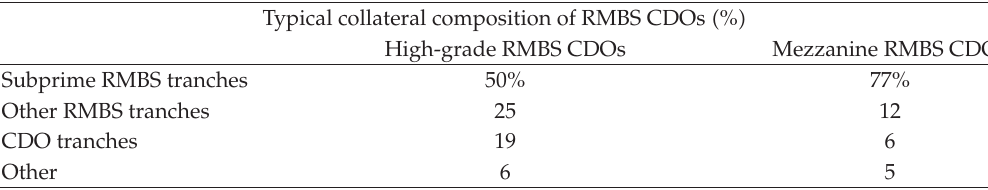
Table 2: Typical collateral composition of RMBS CDOs (cid:2) % (cid:3) ; source: Citigroup. Typical collateral composition of RMBS CDOs (cid:2) % (cid:3)